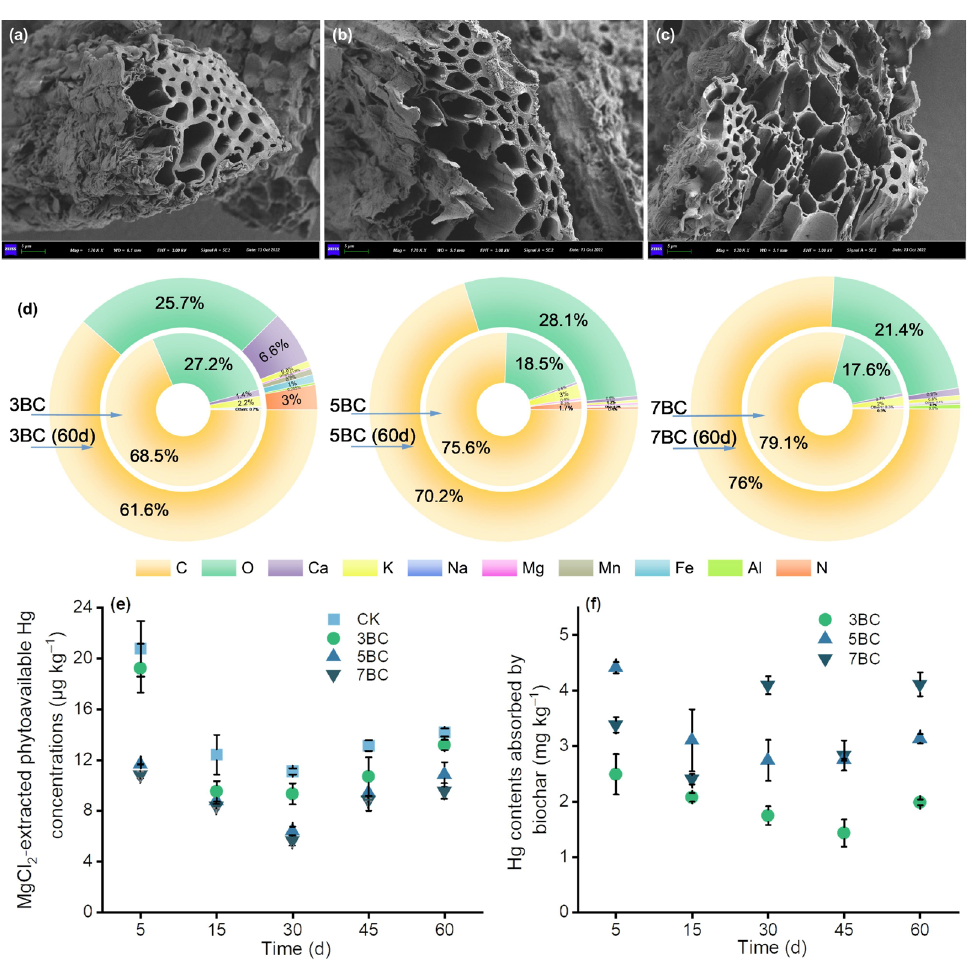
Figure 1. SEM images of fresh biochar at 300 °C ( a ), 500 °C ( b ) and 700 °C ( c ). The element composition of the biochar removed from soil ( d ). The phytoavailable Hg contents in the soil ( e ) and the concentration of Hg in BC ( f ). Data are presented as mean ± standard deviation (SD), n = 3. CK, control; 3BC, 300 °C biochar treatment; 5BC, 500 °C biochar treatment; 7BC, 700 °C biochar treatment.